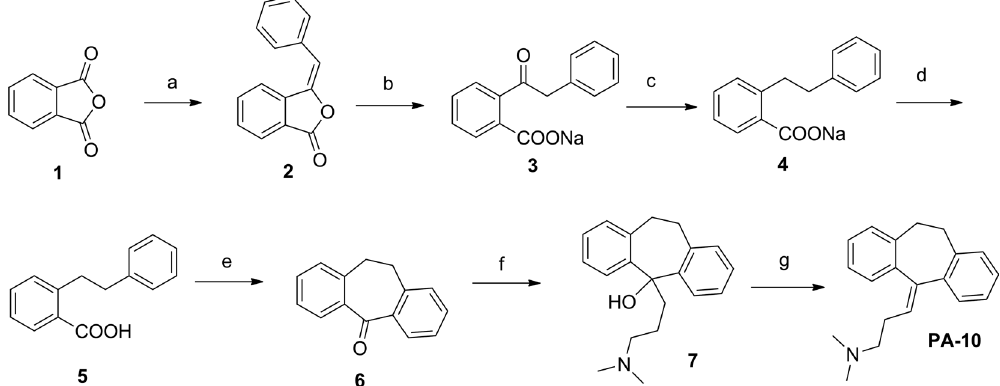
Figure 3. General Synthesis of compound PA-10. Reagents and conditions: ( a ) Phenylacetic acid, CH 3 COONa, fusion at 200 °C, 5 h; ( b ) MeOH, NaOH; ( c ) PEG, hydrazine hydrate, NaOH, 110 to 180 °C; ( d ) HCl; ( e )